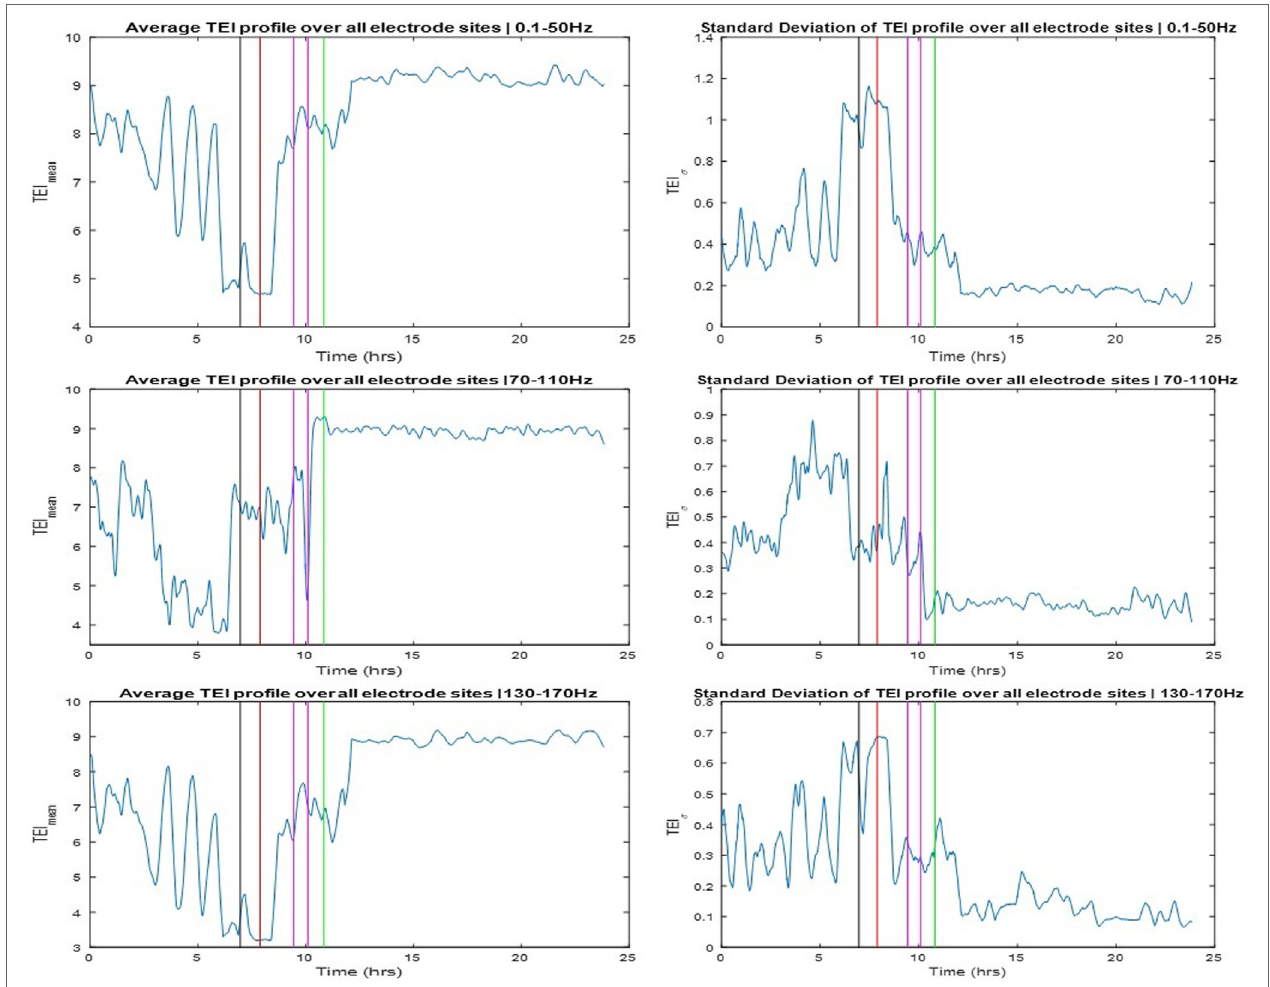
FigUre 4 | Left panels: Averaged total effective inflow (TEI) values across brain sites over time (TEI mean profiles) for three frequency bands (low frequency band top, high frequency band middle, and ultrahigh frequency band bottom panels—see text for more details). Right panels: Standard deviation of TEI values across brain sites over time (TEI σ profiles) for the same frequency bands. Color coding of the vertical lines same as the one for the arrows in Figure 3